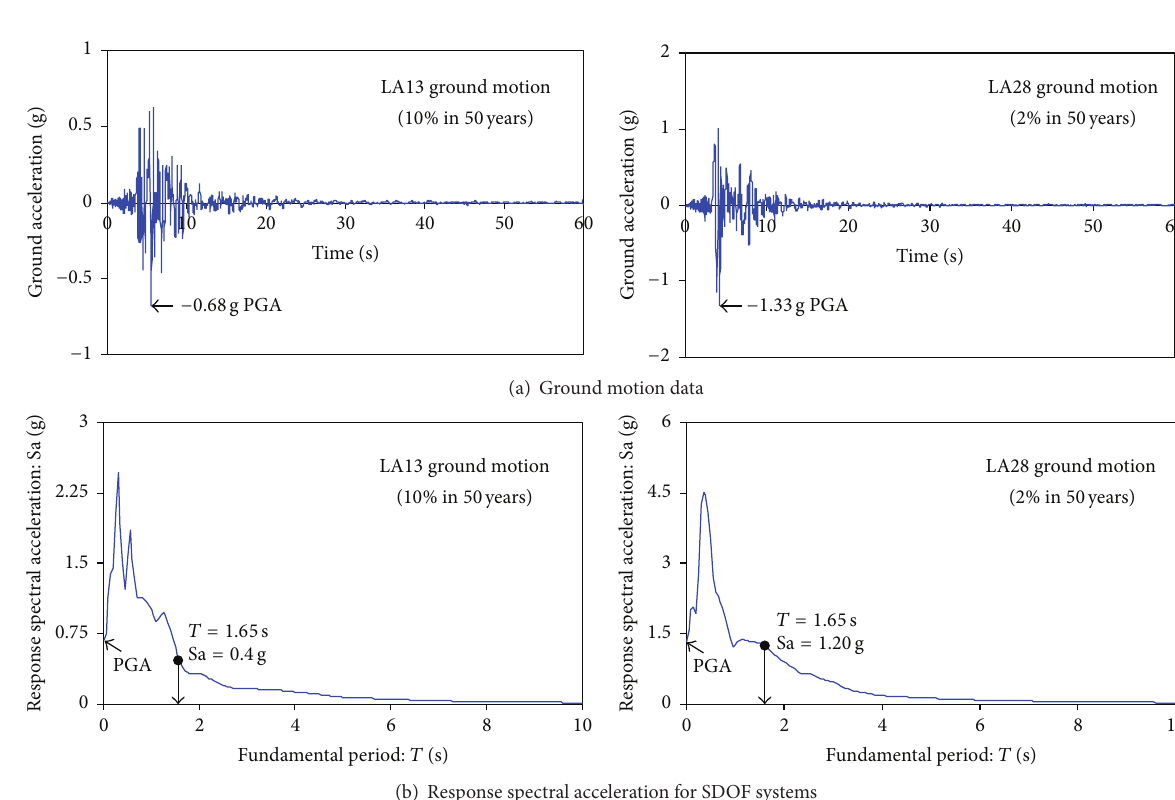
Figure 5: Comparisons of experimental test results to analytical test results.